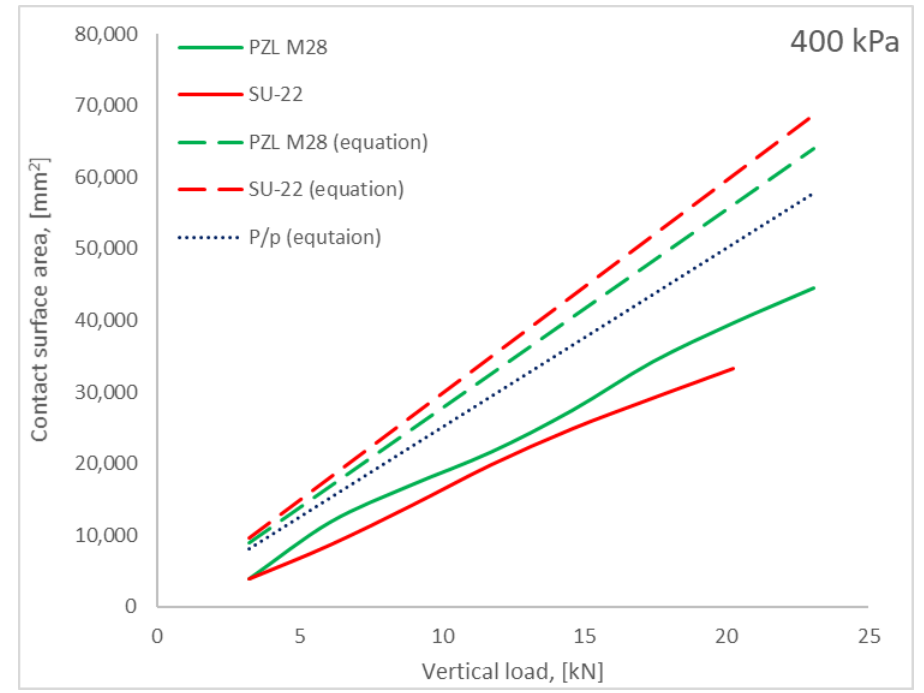
Figure 15. Contact surface area of the aircraft tire with the surface, in relation to the load for the wheel pressure of 400 kPa.